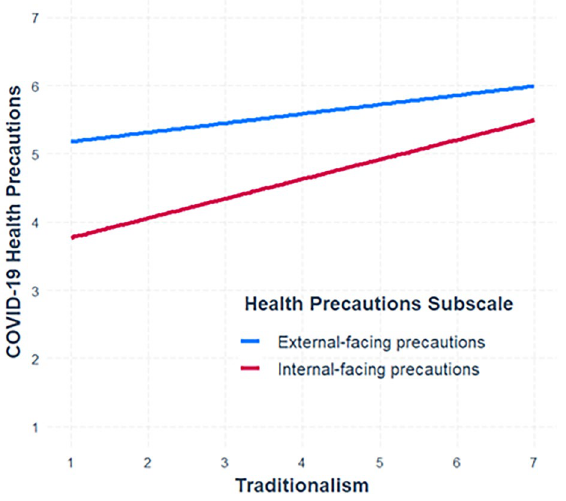
Figure 4. Results of a restricted maximum likelihood moderated mixed linear regression in which COVID- 19 health precautions were regressed on traditionalism, a health precautions indicator variable (e.g., either internal-facing or external-facing), and the interaction between those two variables in the pooled sample. The model included participants nested within study sites as random effects. To test this interaction, there were two observations for each participant; the first observation contained each participants’ internal-facing precautions score, and the second their external-facing precautions score. We simultaneously created an indicator variable specifying which health precautions subscale corresponded with each observation. Simple slopes were then plotted in the figure. There was an interaction between health precautions subscale and traditionalism ( B = 0.16, SE = 0.01, t (7,535) = 12.76, p < 0.001). A simple slopes analysis revealed that the correlation between traditionalism and internal-facing precautions ( B = 0.29, SE = 0.01, t (7,535) = 23.17, p < 0.001) was